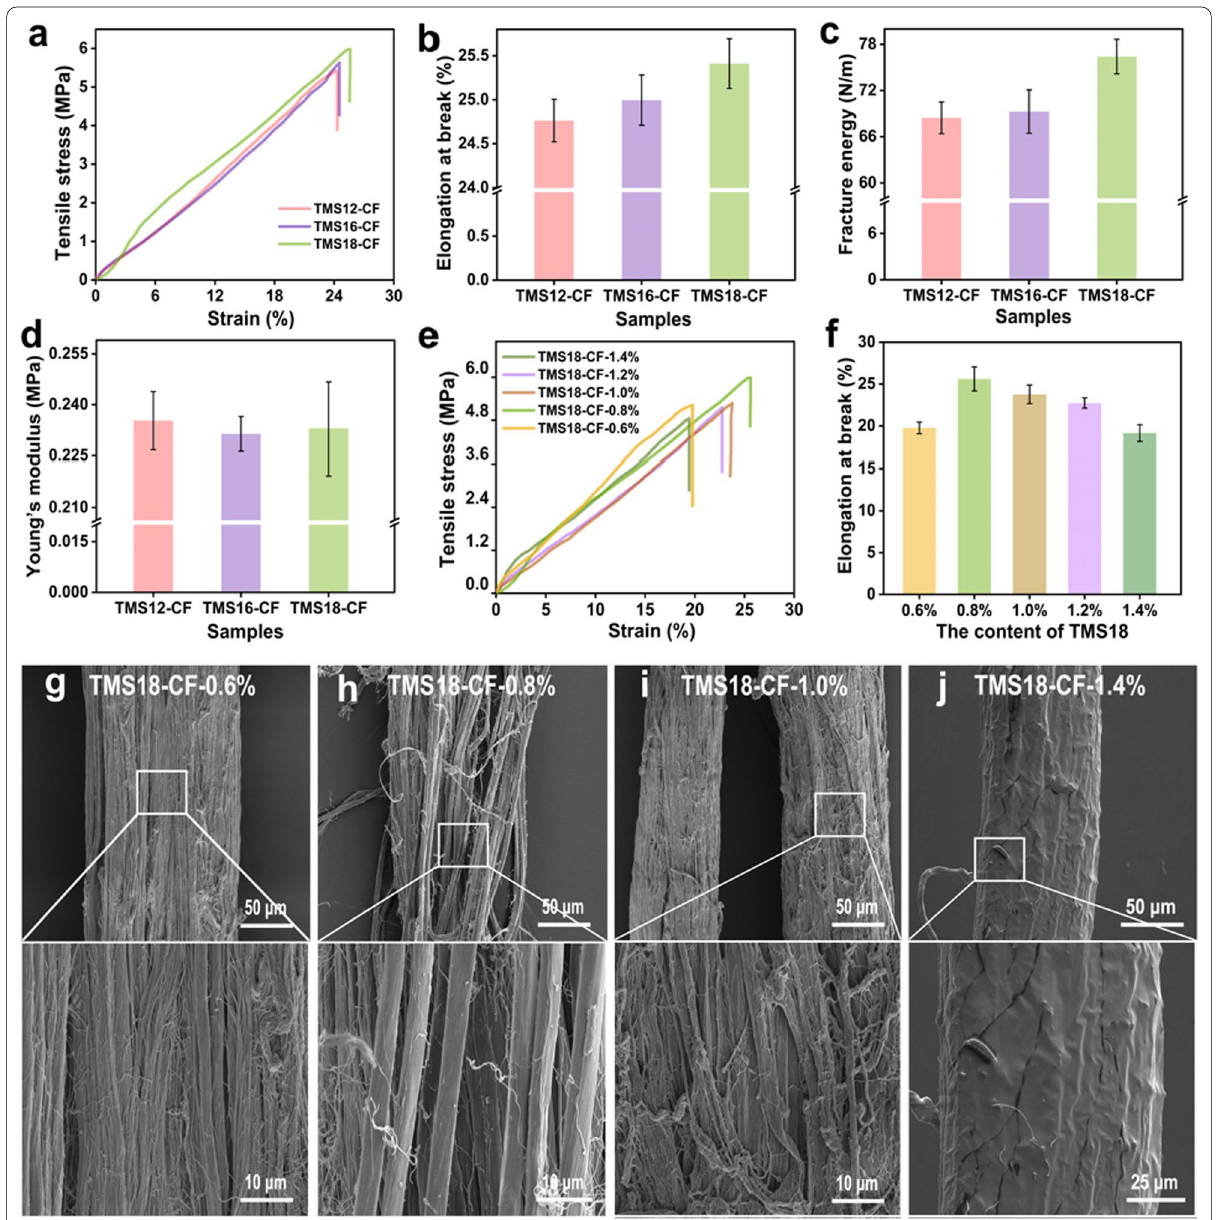
Fig. 6 Stress–strain curves ( a ), elongation at break ( b ), fracture energy ( c ), and Young’s modulus ( d ) of different collagen fibers, stress–strain curves of TMS18-CF with different content of TMS18 ( e ), elongation at break of TMS18-CF with different content of TMS18 ( f ), SEM images of TMS18-CF-0.6% ( g ), TMS18-CF-0.8% ( h ), TMS18-CF-1.0% ( i ), TMS18-CF-1.4% ( j